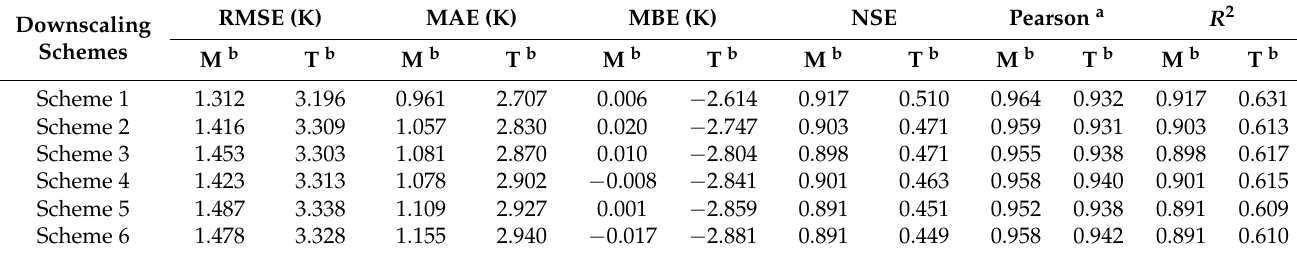
Table 9. Accuracy evaluation indicators of MFGWML and TsHARP for the six downscaling schemes performed in the entire city of Beijing (excluding water